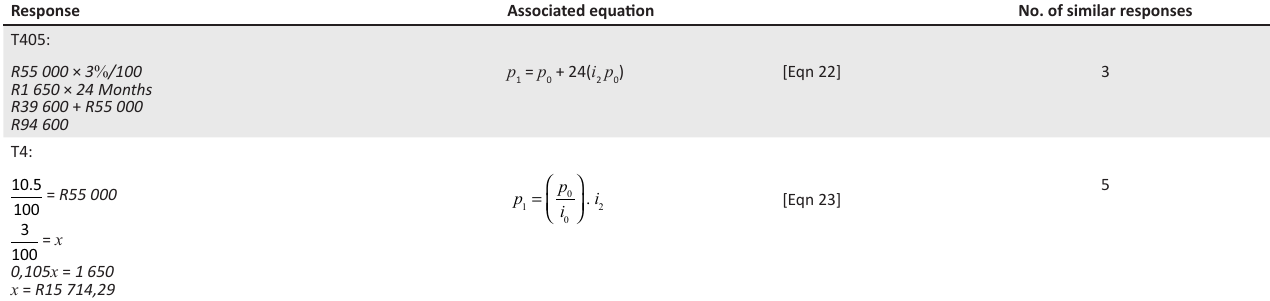
TABLE 7: Responses taken as ‘other’. Response Associated